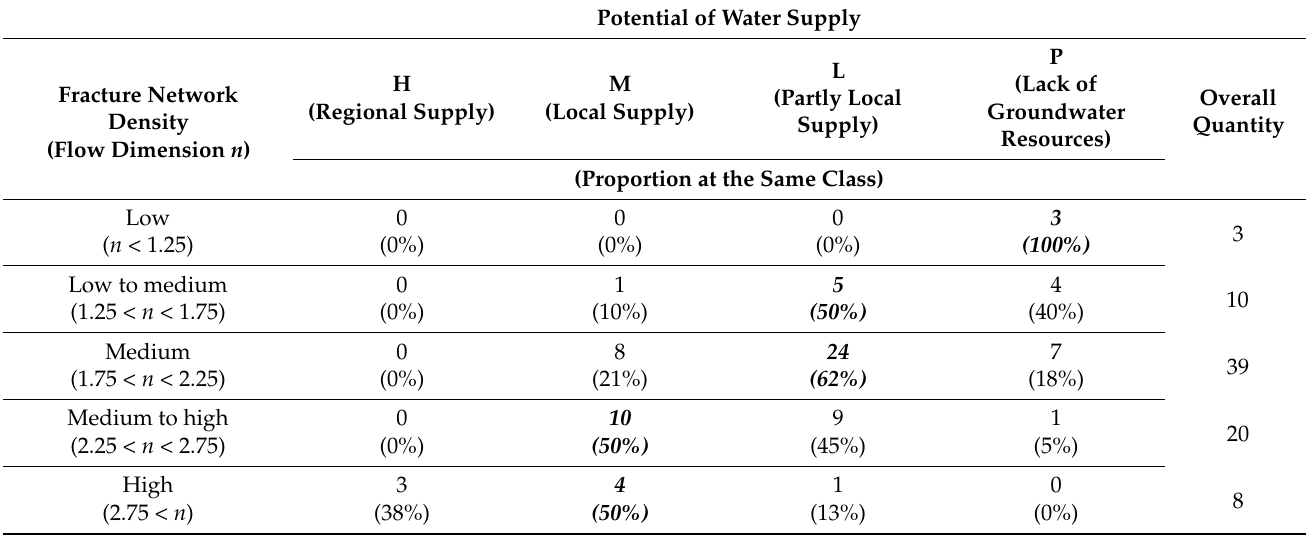
Table 5. Integration of n and K